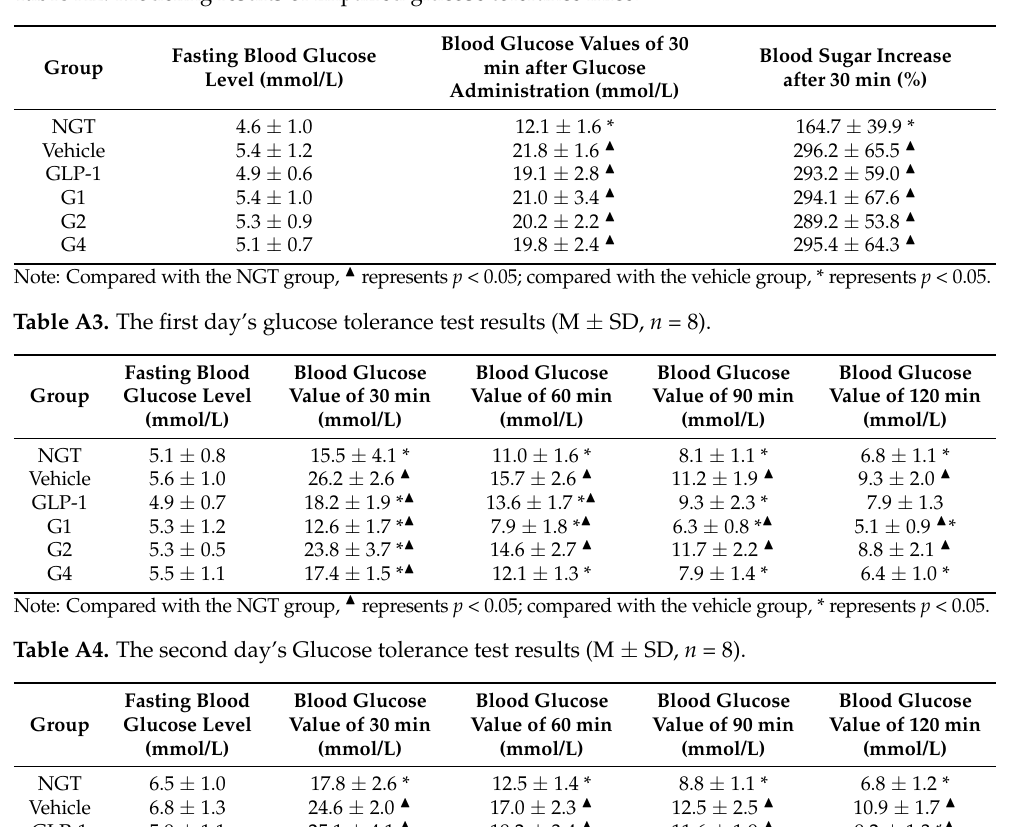
Table A2. Modeling results of impaired glucose tolerance mice.